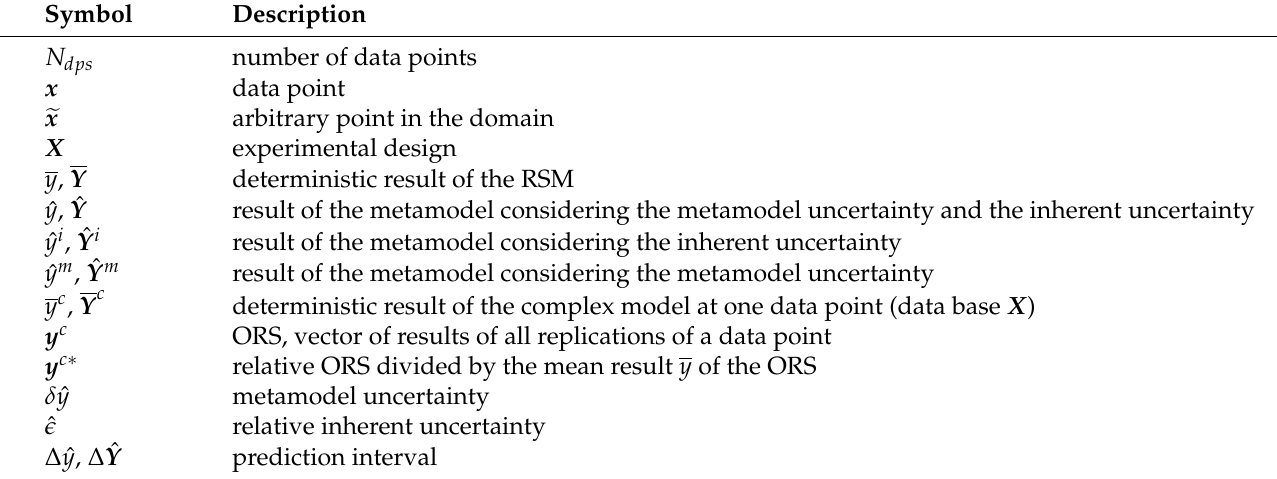
Table 1. Symbols applied for the RSM, metamodel uncertainty and inherent uncertainty; vectors are highlighted in bold and matrices are symbolised with bold capitals, e.g., y is the result at one point and Y for multiple points.